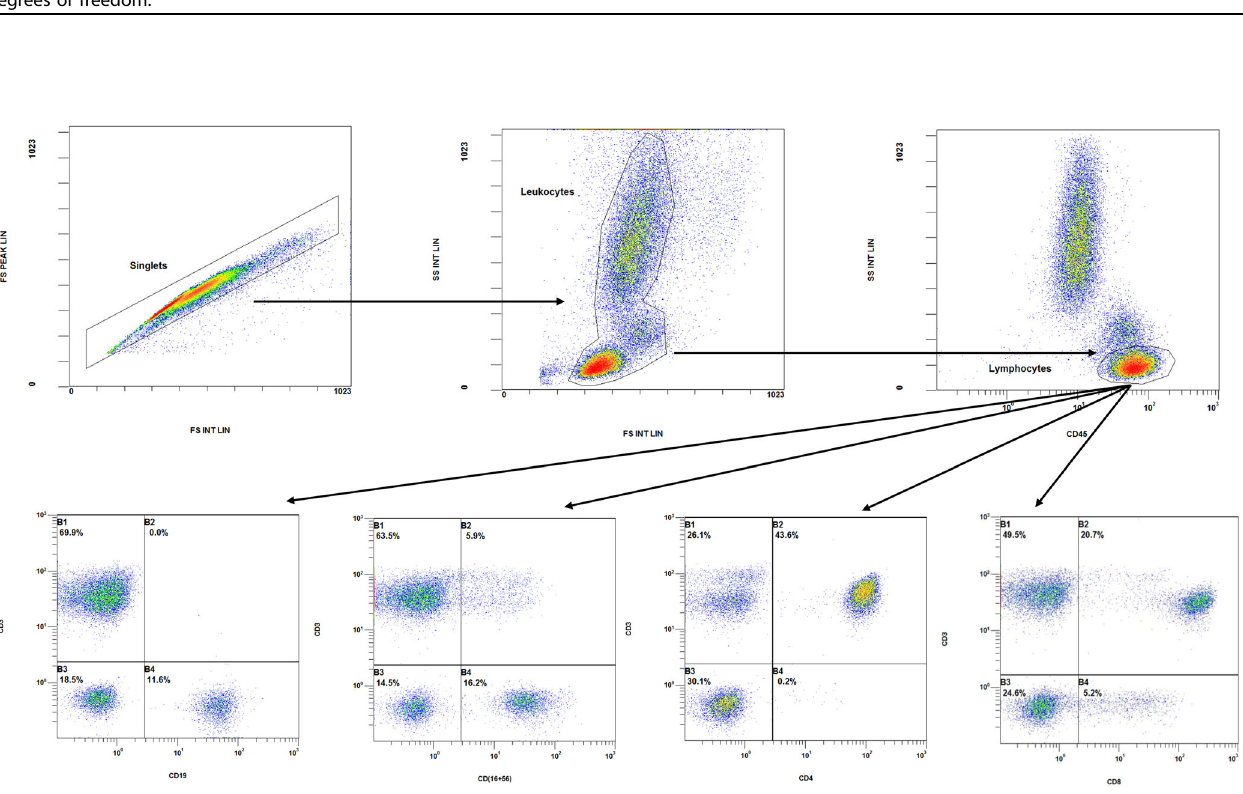
Fig. 4 Flow cytometry analysis of immune cell population distribution. Cytometric plots with gating strategy used for immunophenotyping of CD3 − CD19 + , CD3 − CD(16 + 56) + , CD3 + CD(16 + 56) + , CD3 + CD4 + , CD3 + CD8 + cells from peripheral blood